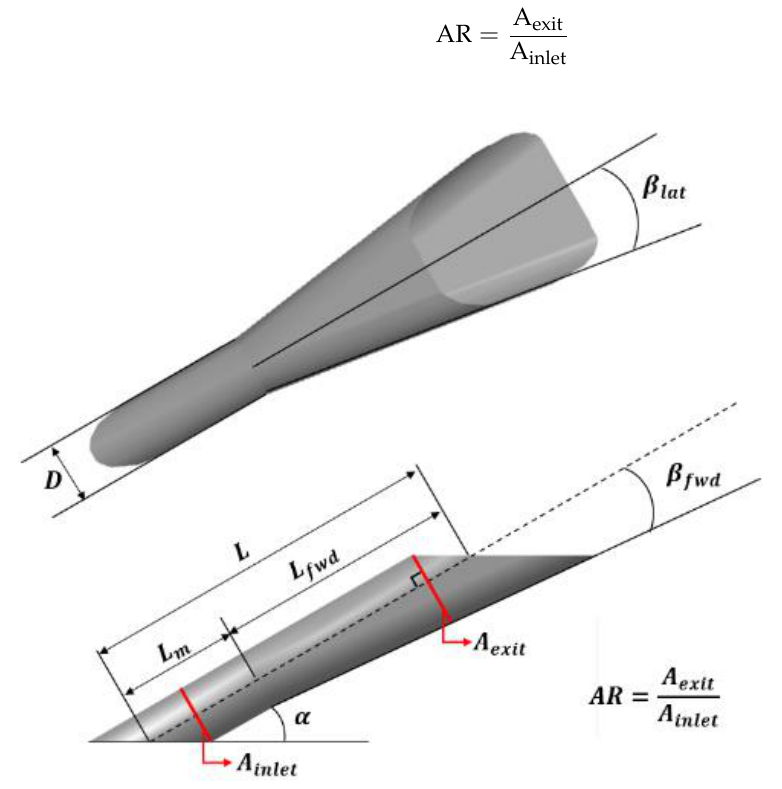
Figure 6. Shape parameters of the fan-shaped hole.